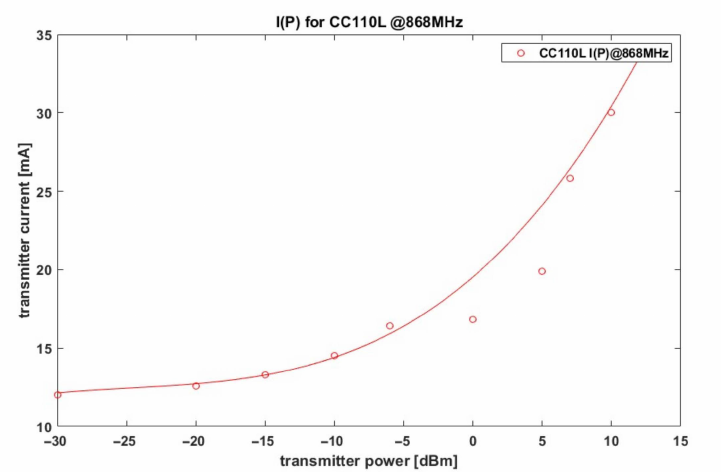
Figure 6. Dependence of the current consumed by the CC110L for different transmitter